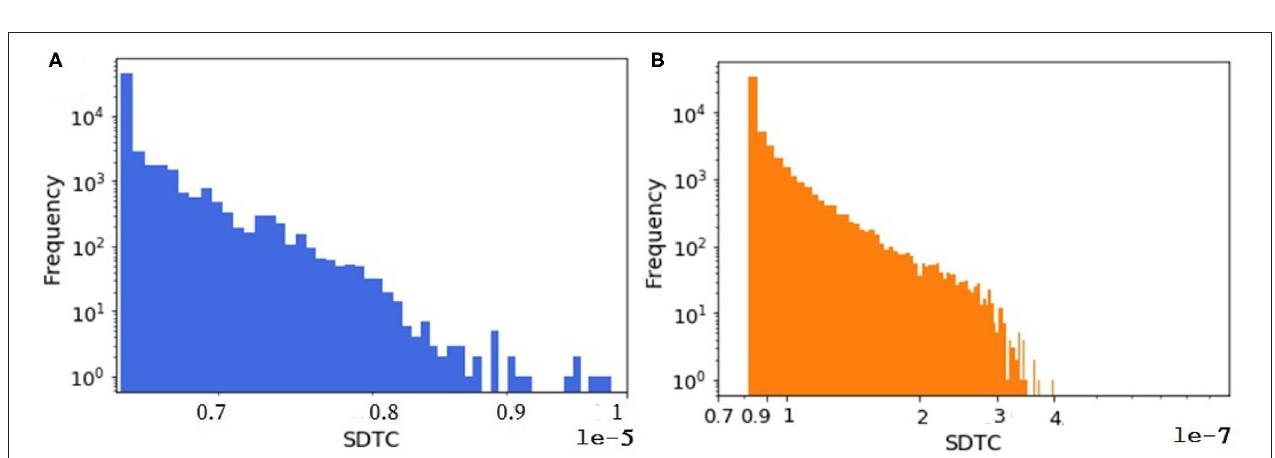
FIGURE 9 | The distribution of weighted SDTC for (A) the real dataset and (B) one realization of a synthetic data. In both networks, n =